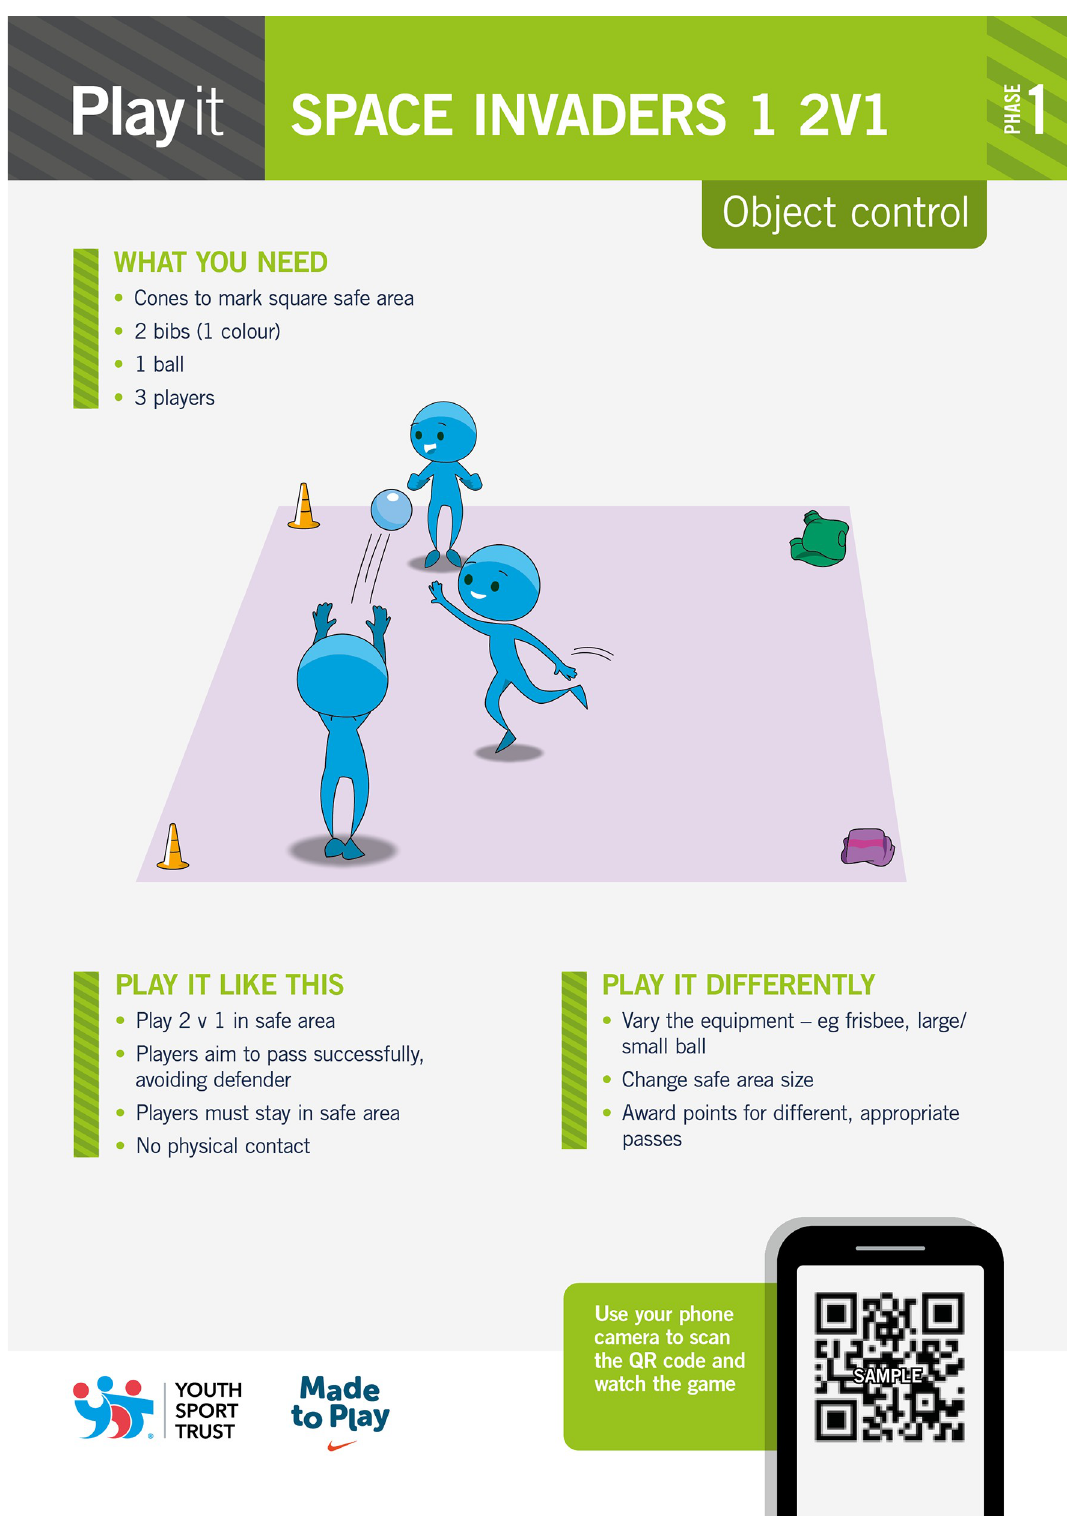
Fig 1. Example of a MOGBA activity (Space Invaders 4, Phase 3, Object Control) front of card ‘Play it’.